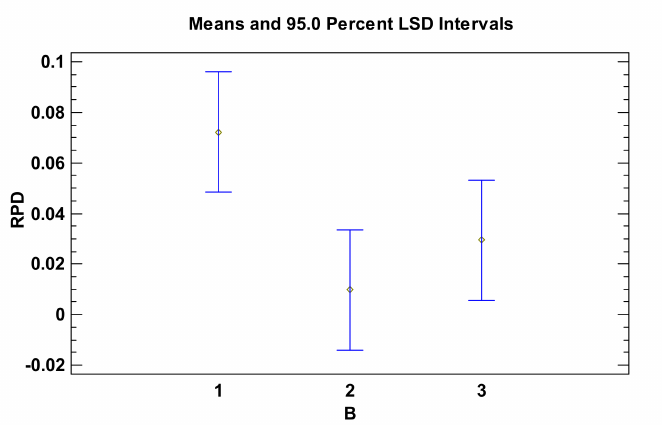
Figure 5. Means plot at the 95% confidence level LSD intervals for RPD metric.